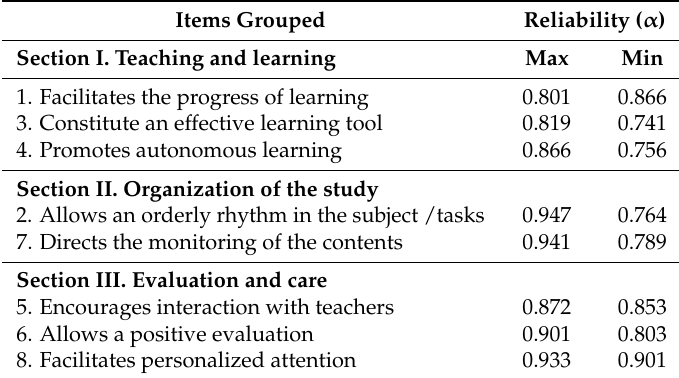
Table 4. Grouping of